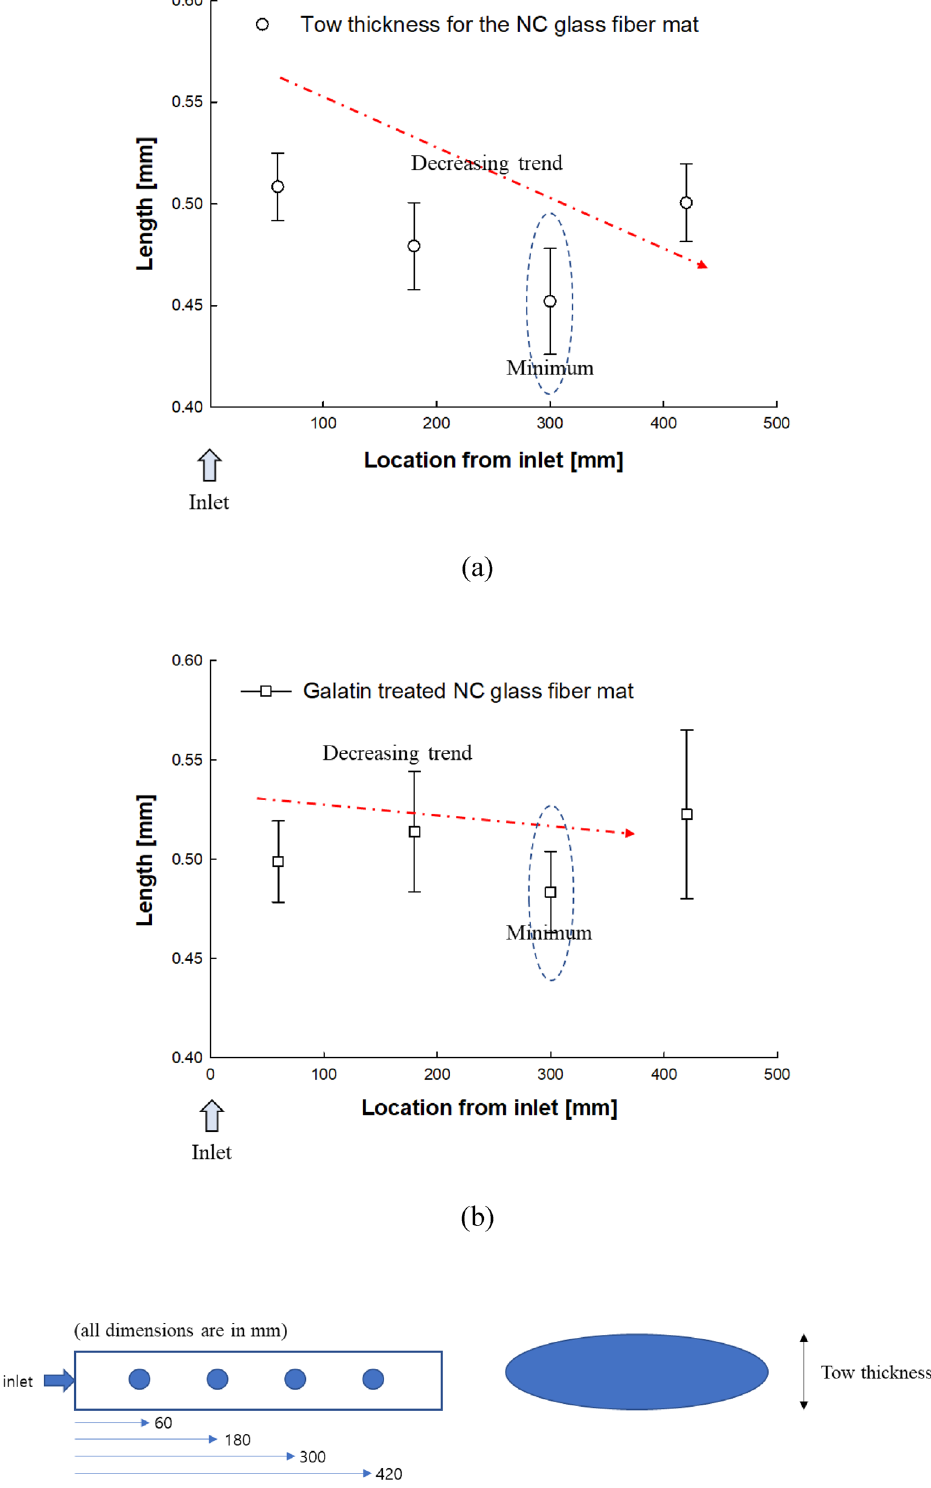
Figure 6. Tow thickness at cross-sections of the deformed tow at different positions of mold: untreated NC glass fiber mat ( a ), gelatin-treated NC glass fiber mat ( b